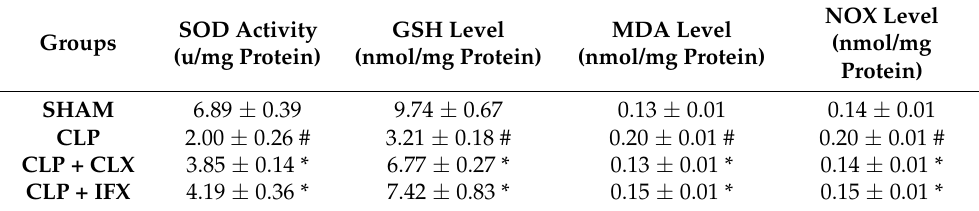
Table 2. CLX and IFX enhance hepatic oxidative and antioxidant profiles in septic rats.